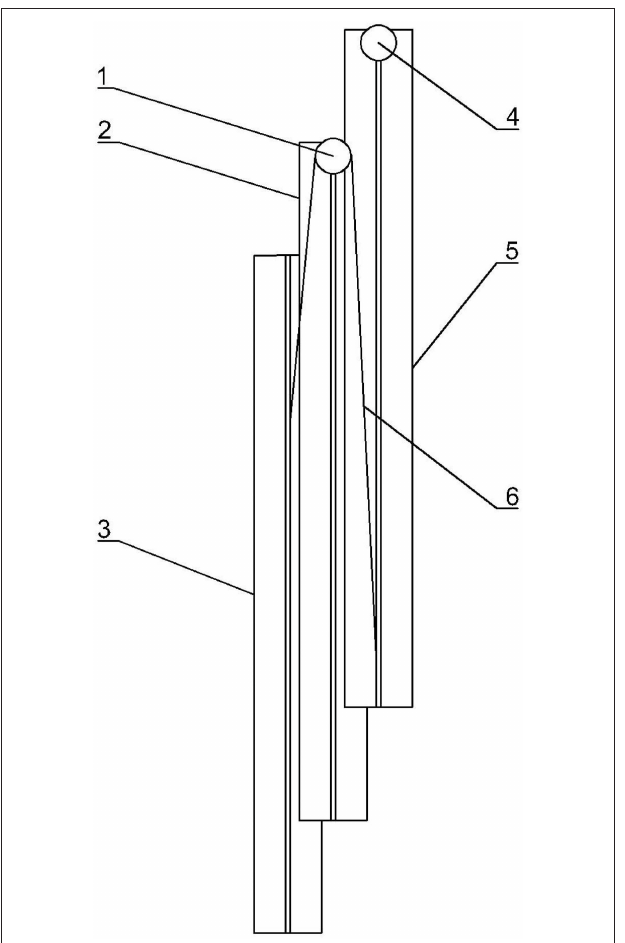
FIGURE 5 | Chain connection of the guide rails (1: second sprocket, 2: second-level guide, 3: first level guide, 4: third-level sprocket, 5: third-level guide, 6: chain).